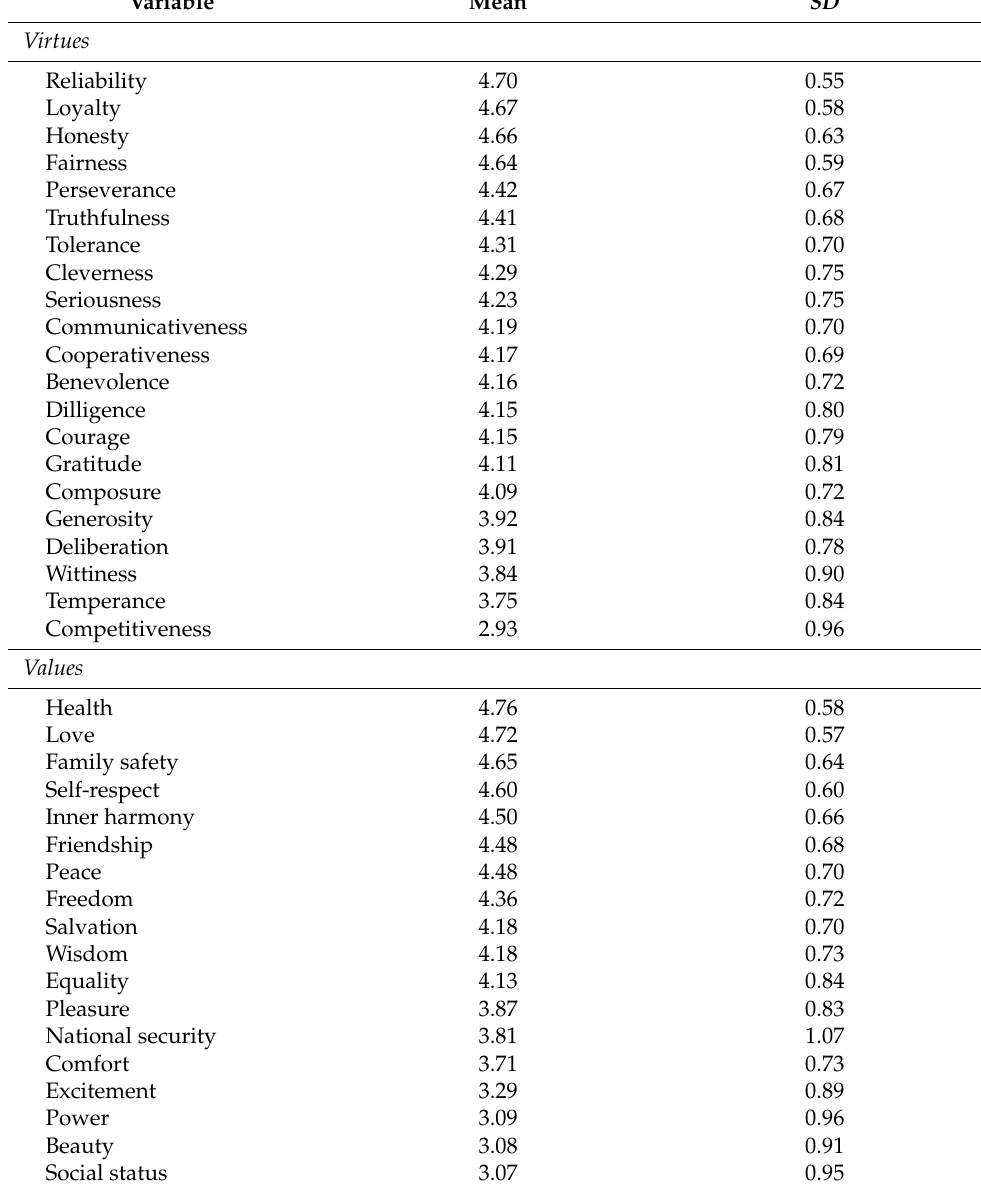
Table 2. Mean ratings of virtues and